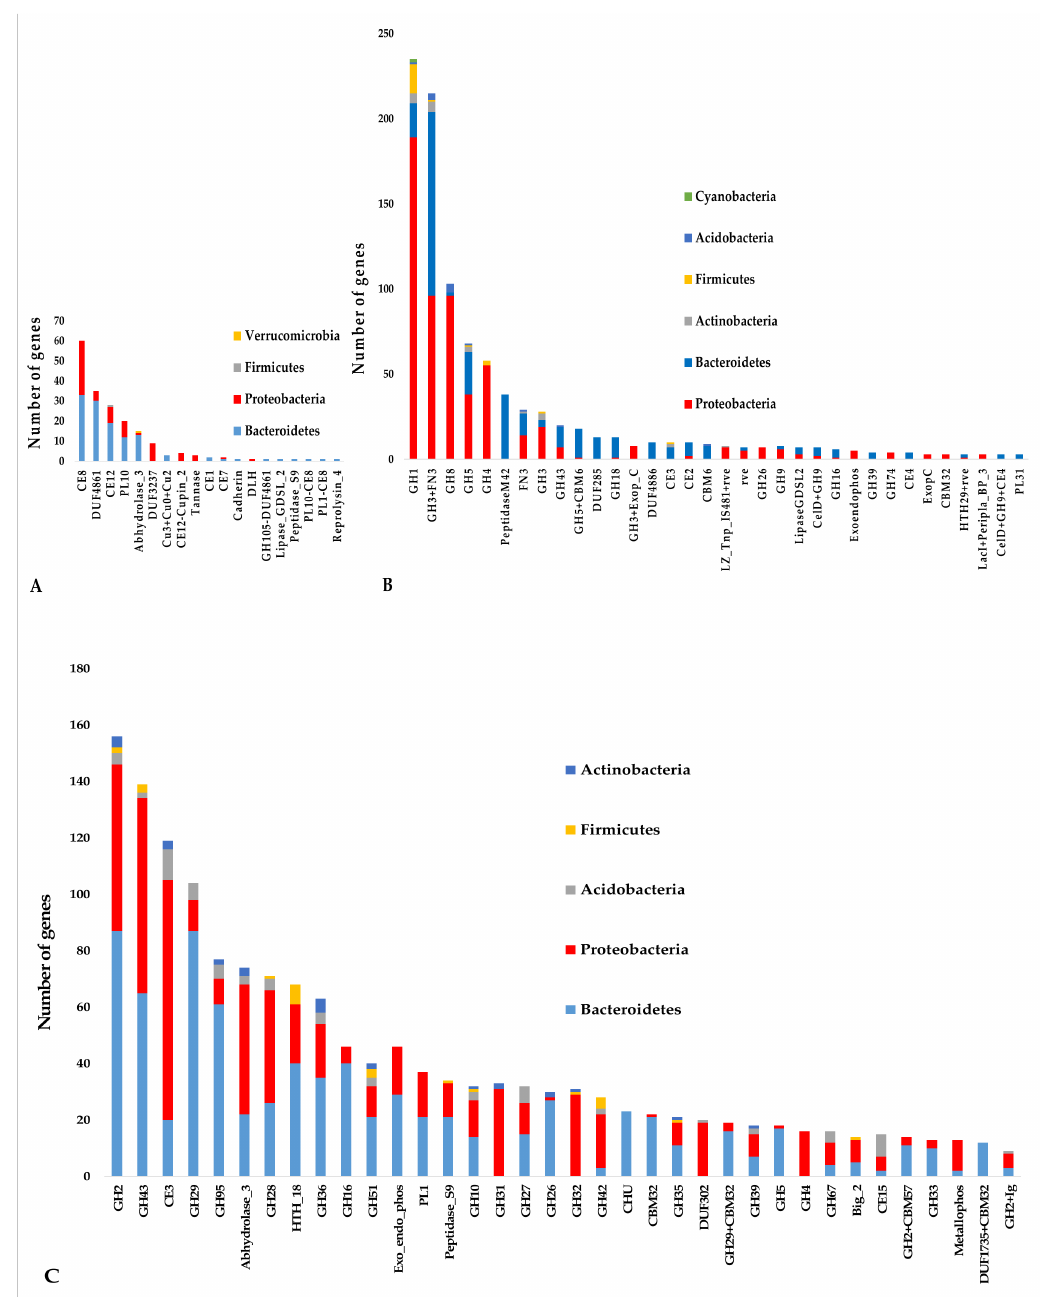
Figure 6. ( A ) Bacterial phyla possess domain-containing complete ORFs encoding protein/enzyme involved in lignocellulose pretreatment, ( B ) cellulose, and ( C ) hemicellulase. CE: carbohydrate esterase; PL: polysaccharide lyases; GDLS: motid Gly-Asp-Ser-Leu sequence; CBM: carbohydrate binding model; GH: glycoside hydrolase family; DUF: domain of unknown function; HTH: helix-